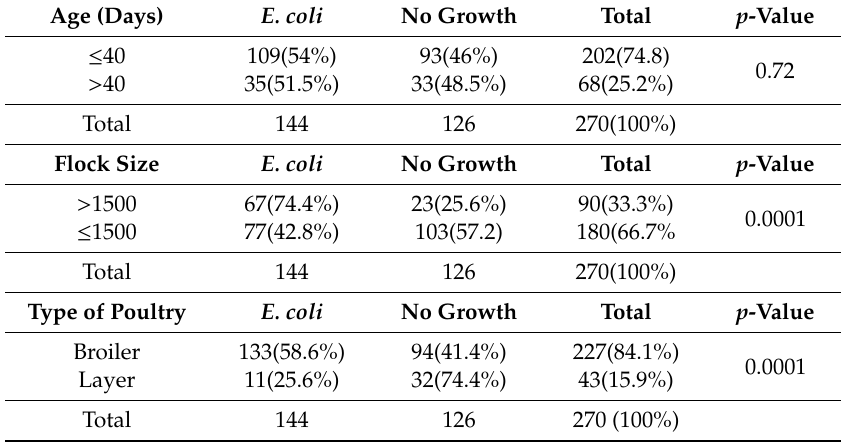
Table 1. Growth of E. coli in the poultry liver samples according to age of dead poultry, flock size and type of poultry.